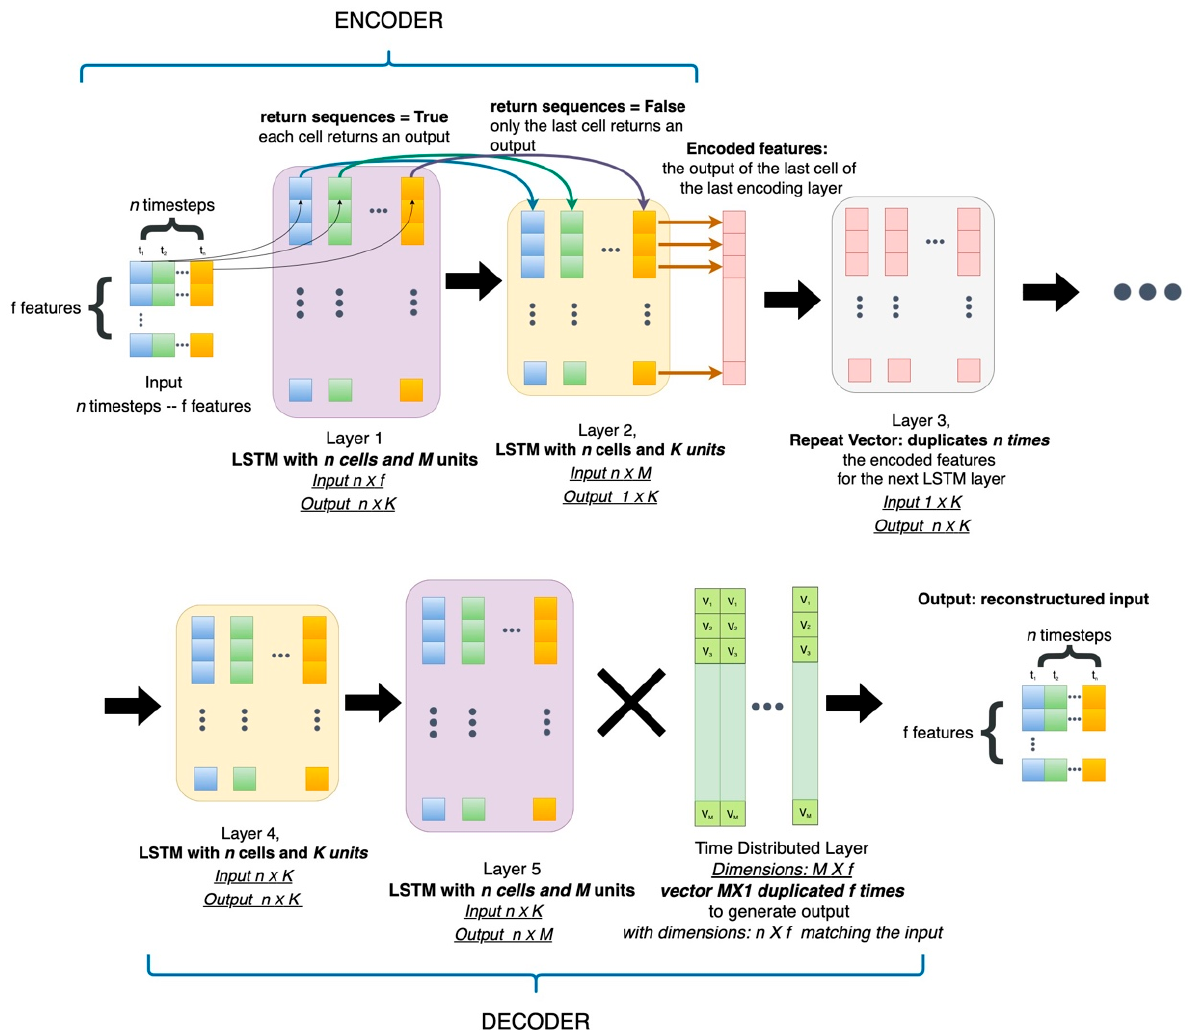
Figure 8. The architecture of LSTM AutoEncoders.